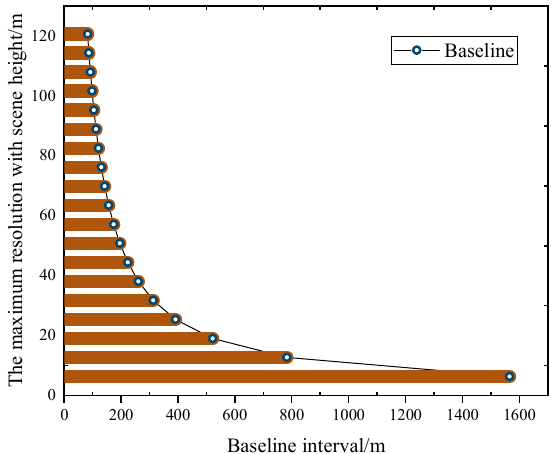
Figure 11. Effect of baseline interval on scene height.